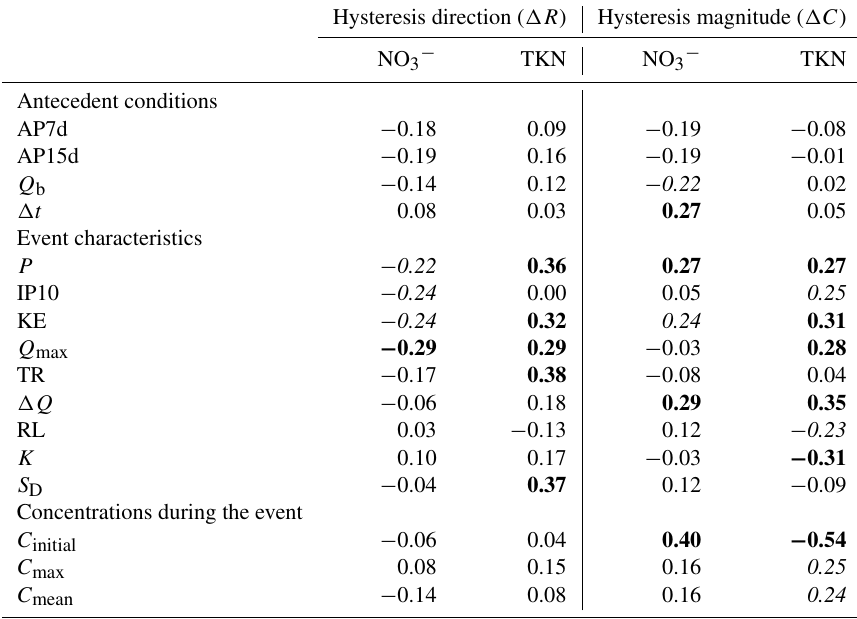
Table 2. Pearson correlation coefficients between hysteresis descriptors ( (cid:49)R and (cid:49)C ) and event characteristics. Values displayed in bold indicate that the correlation is significant at the 0.01 level, and italics indicate that the correlation is significant at the 0.05 level.